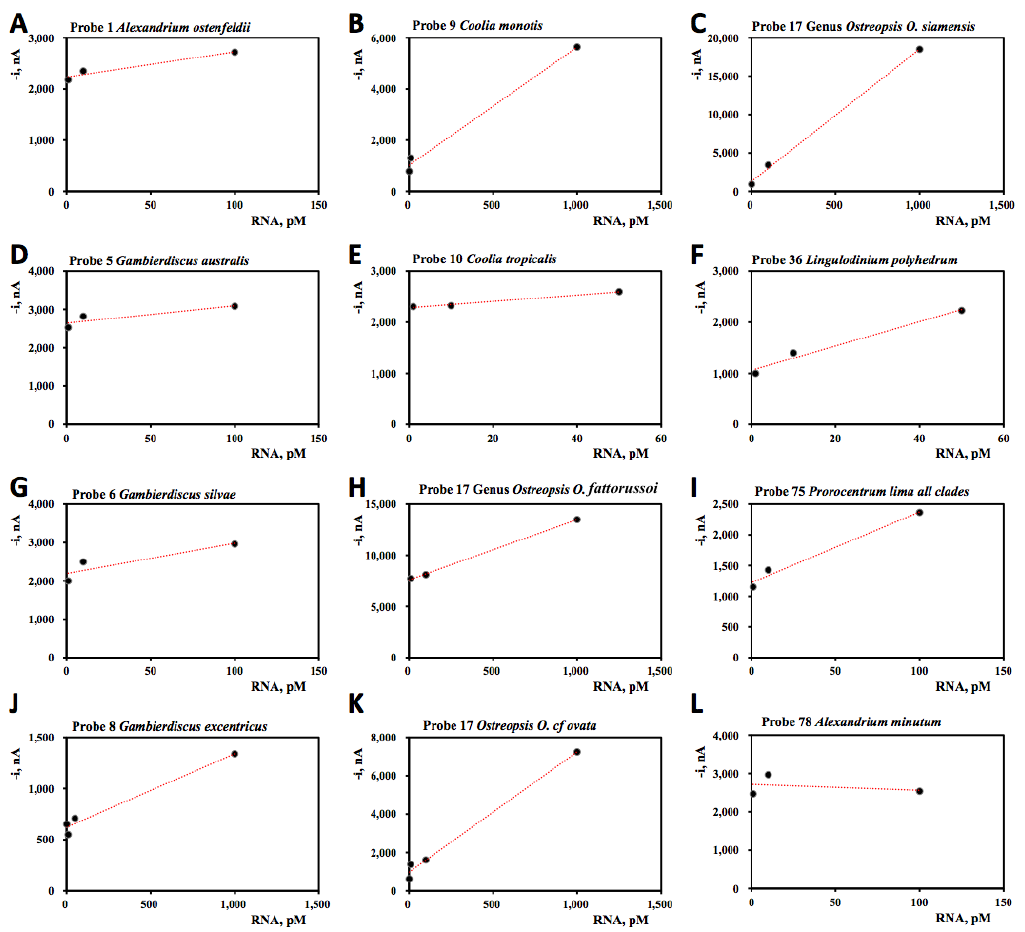
Figure 8. Concentration curves for probes where RNA was available. Regression statistics are present in Table 4 and cell counts inferred from 1 pM of RNA are presented in Table